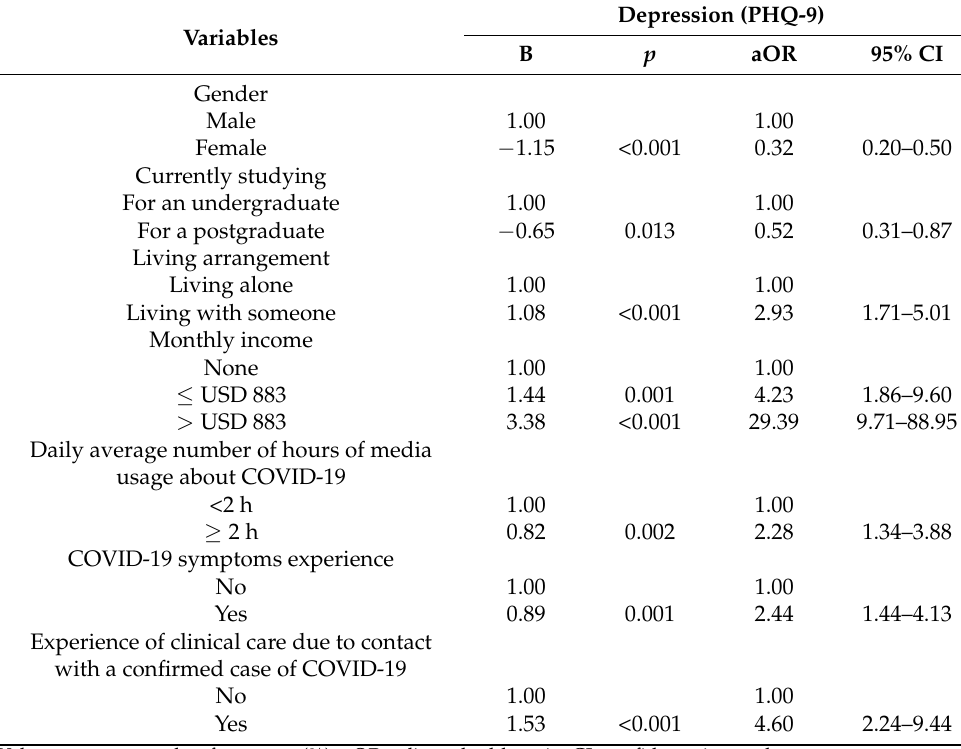
Table 6. Factors associated with depression among international students during the COVID-19 ( N =